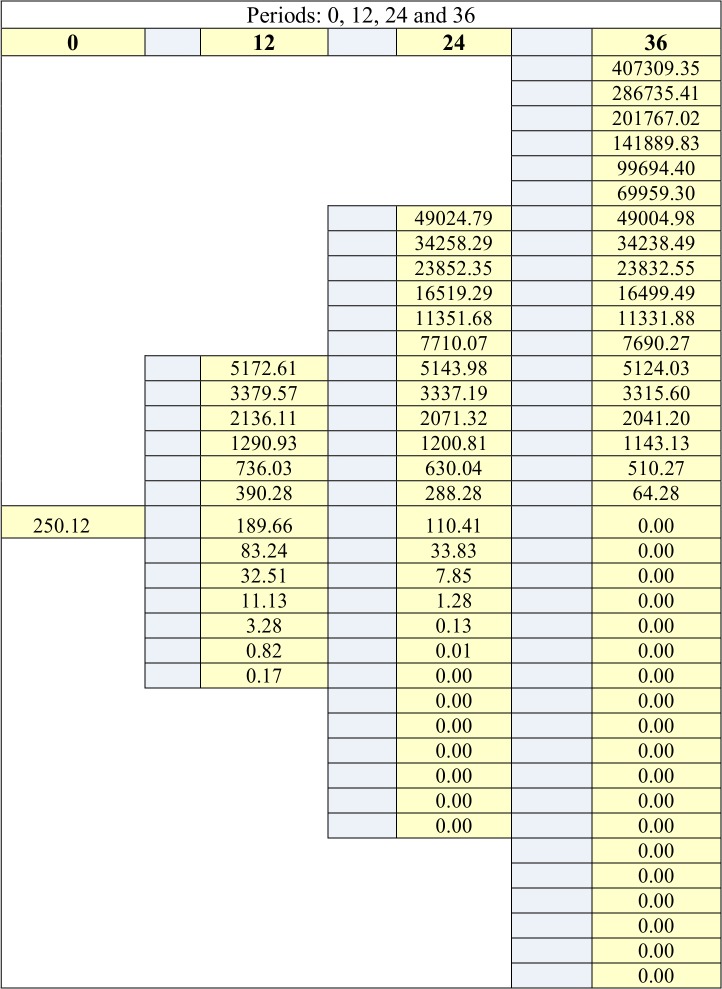
Call option tree.